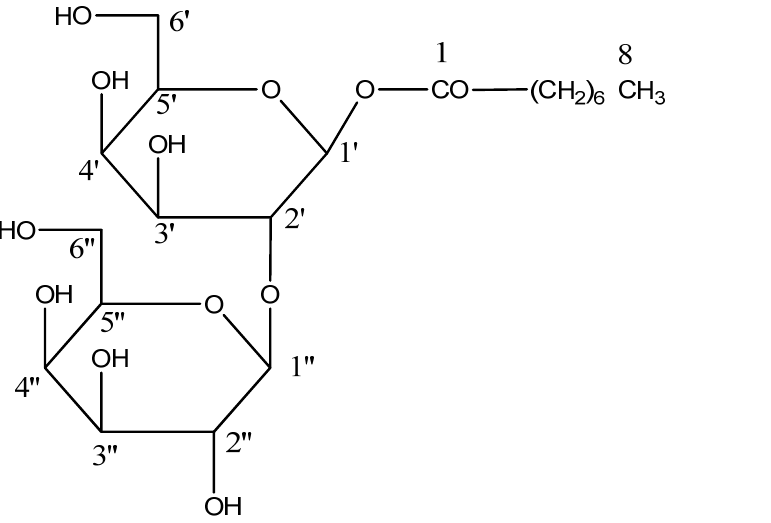
Scheme. 2. Isolated compound n-octanoyl- β -D-glucopyranosyl-2 ′ - β -D-glucopyranoside (AB